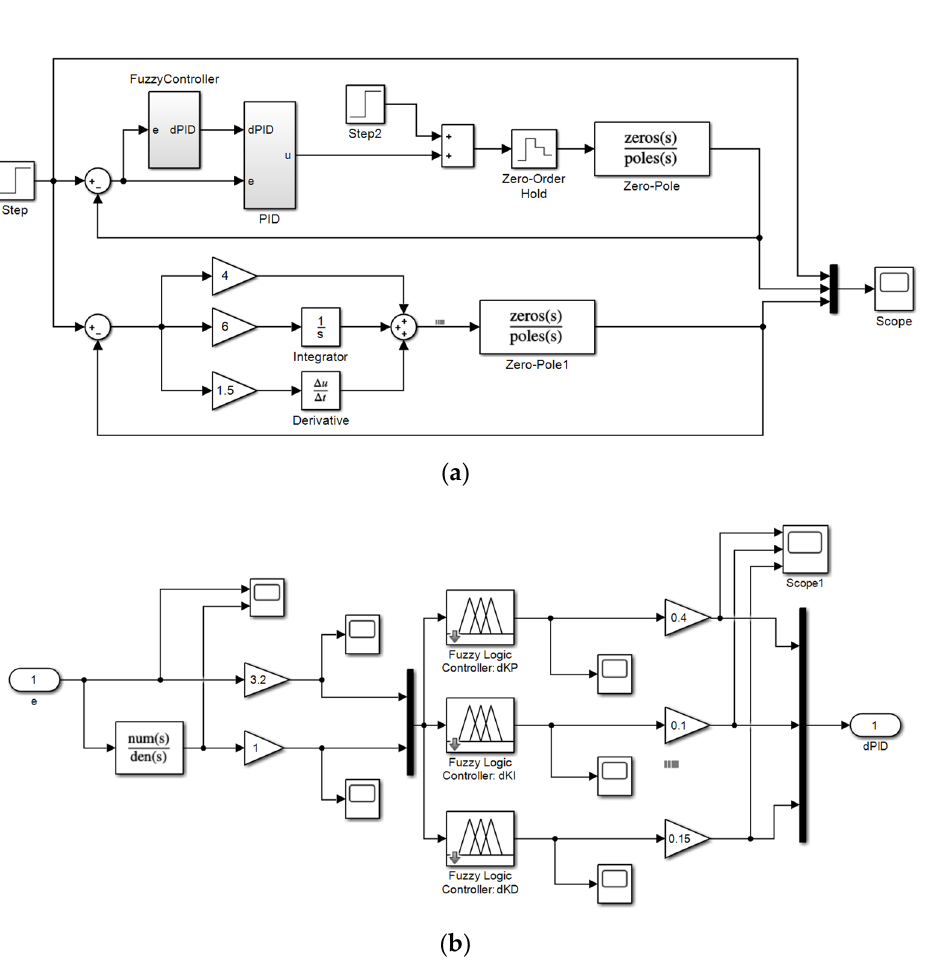
Figure 11. Simulation model of fuzzy PID deflection control system: ( a ) Comparative simulation model between Fuzzy PID controller and traditional PID; ( b ) Fuzzy controller simulation